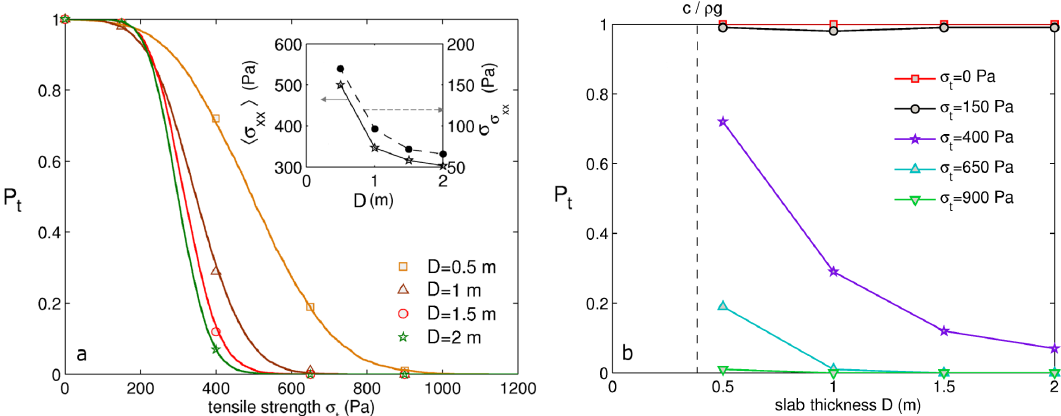
Figure 4. (a) Probability of slab tensile failure P t within the simulated system (partial-slope release) as a function of the tensile strength σ t for different slab thickness values and a constant correlation length (cid:15) = 0 . 5m, slab density ρ = 250kgm − 3 and Young’s modulus E = 1MPa. In the inset, the average tensile stress (cid:104) σ xx (cid:105) and its standard deviation σ are represented as a function of D . (b) P t is represented as a σxx function of D for different tensile strength values and the same value of the other parameters as in (a) .